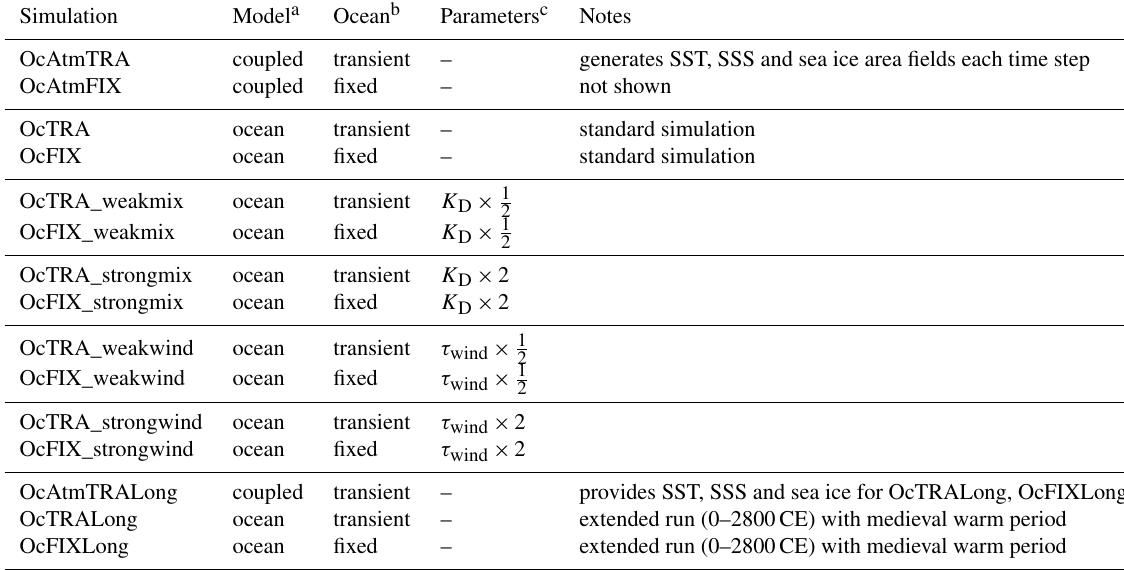
Table 1. Simulations performed in this study.